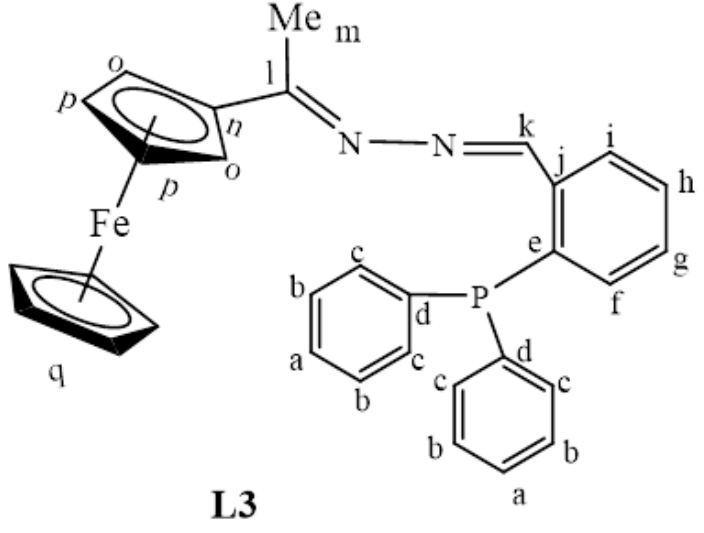
3.2.4. Preparation of Ferrocenyl(Pyridyl)imine Ligand, L4 Figure 25. The chemical structure of L3 . Figure 25. The chemical structure of L3 . 2-Pyridine carboxaldehyde (0.150 g, 0.619 mmol) was added to a solution of L1 (0.666 g, 0.616 mmol) in ethanol (30 mL). The solution was refluxed for 48 h at 85 ◦ C. After 48 h, the solvent was removed by rotary evaporation, and a sticky red solid was obtained. The TLC revealed a mixture of products but mainly unreacted L1 and the desired product. Column chromatography was used to separate the mixture of L1 and L4 using ethyl acetate and hexane (3:1) as an eluent. L1 eluted first, followed by L4 . L4 contained trace amounts of 2-pyridine carboxaldehyde extracted into deionized water by washing a DCM (30 mL) solution of L4 and 2-pyridine carboxaldehyde with deionized water (30 mL) three times. The DCM layer was then collected, dried over anhydrous magnesium sulfate, and the DCM solvent was removed by using a rotary evaporator. L4 (Figure 26) was isolated as a sticky red solid, which was dried under vacuum for 6 h.